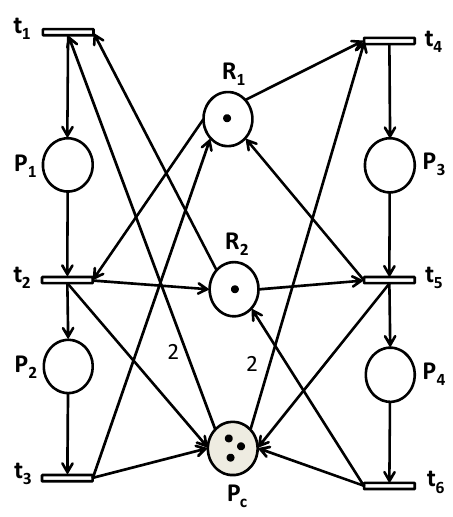
Figure 5. The controlled PN 1.